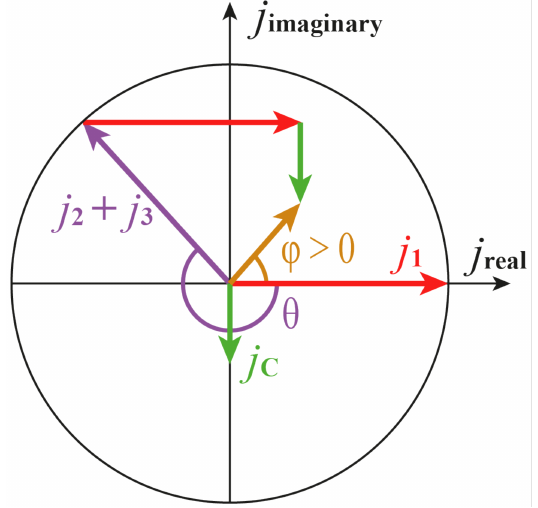
Figure 13. Indication diagram of current density for the case of dominant inductive type conduction: j 1 —current density determined by Formula (17), j 2 + j 3 —current density determined by Formula (20), θ = – ωτ —angle between the vectors j 1 and ( j 2 + j 3 ), ϕ —phase shift angle determined by Formula (32).